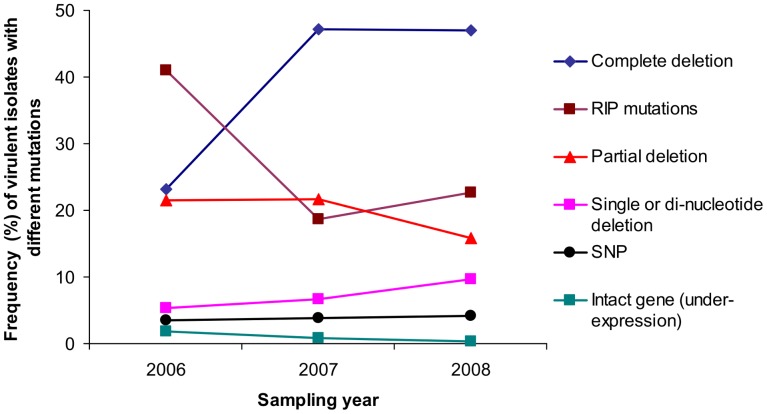
Changes in frequencies of isolates with different mutations leading to the avrLm7 phenotype over three years in the experimental plot at Grignon.Dark blue diamonds, complete deletions; purple squares, RIP mutations; red triangles, partial deletions; pink squares, AA dinucleotide deletions and point deletions; black dots, Single Nucleotide Polymorphisms; green squares, unaltered gene sequence. In 2007 and 2008, isolates collected the same year at the phoma leaf spot stage and at the stem canker stage from the previous growing season residues have been pooled because they correspond to the same generation after the start of the experiment. In 2006, isolates were collected from phoma leaf spots only.